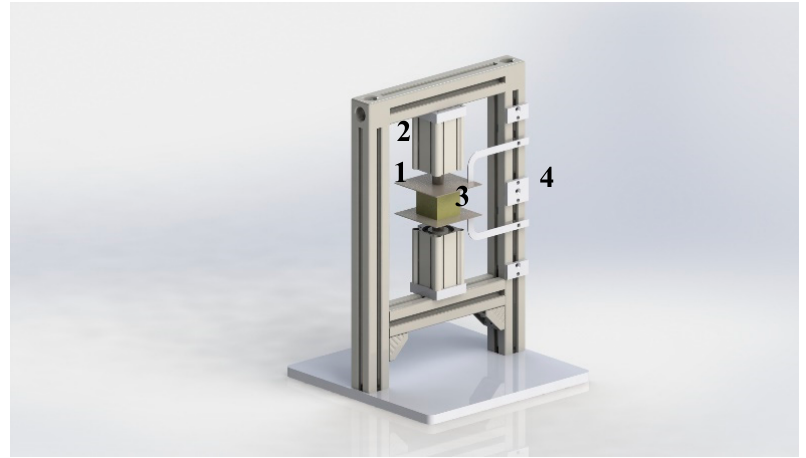
Figure 1. The compression device. 1—The metal plates. 2—Pistons. 3—Porous material. 4—Pressure controls [12].